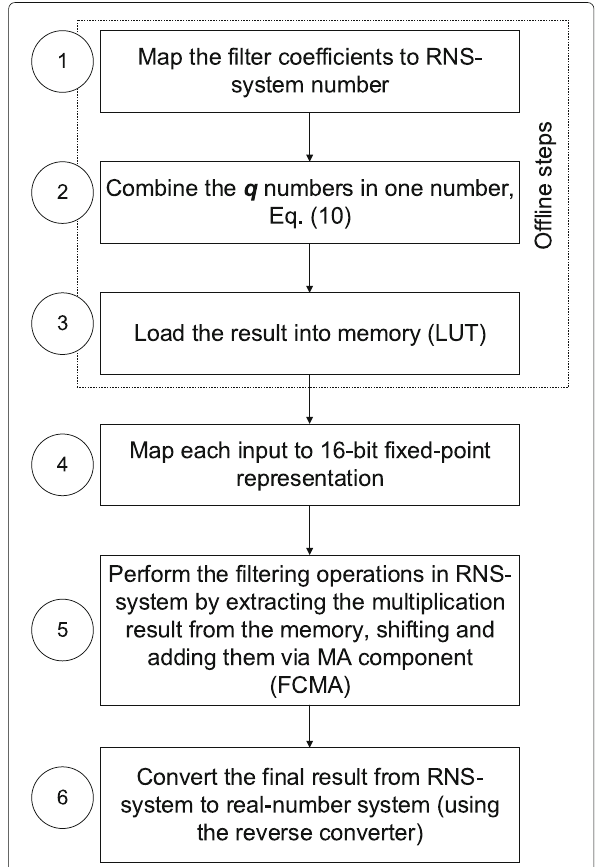
Fig. 3 The RNS-based DWT offline and online steps to perform the filtering operations. The offline steps are performed one time, while the online are performed for each input. q is the number of channels